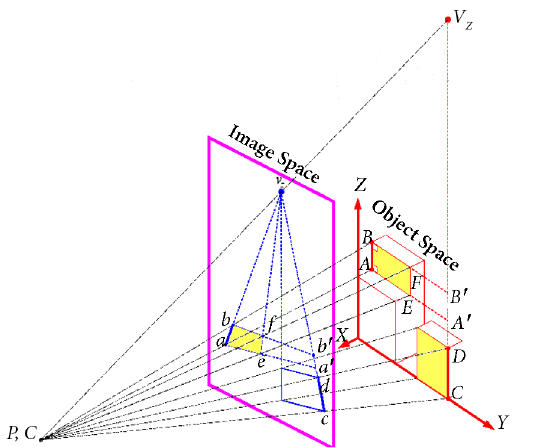
Figure 8. Length calculation of object line using cross-ratio